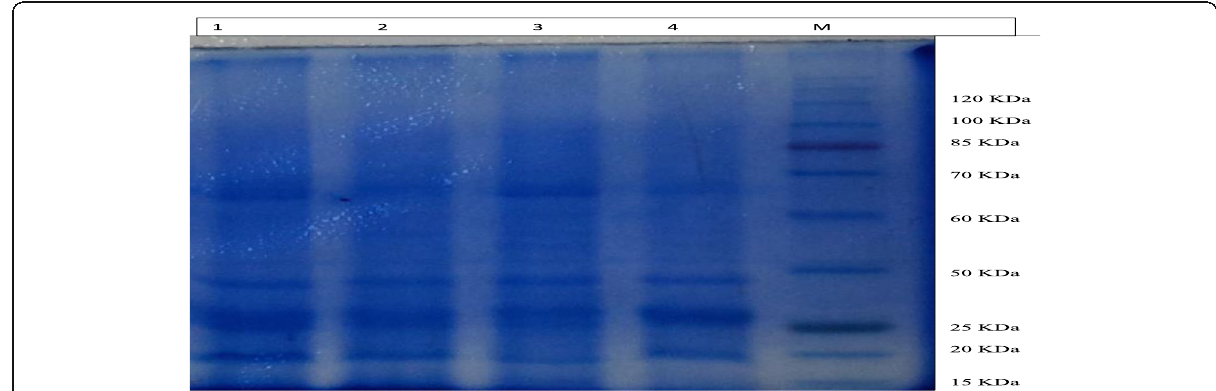
Fig. 4 Patterns of SDS-PAGE electrophoretic protein of E . grandiflorum plants as respond to leaser green light irradiation for different time. 1. 5 min, 2. 10 min, 3. 20 min, 4. 25 min, M. protein marker